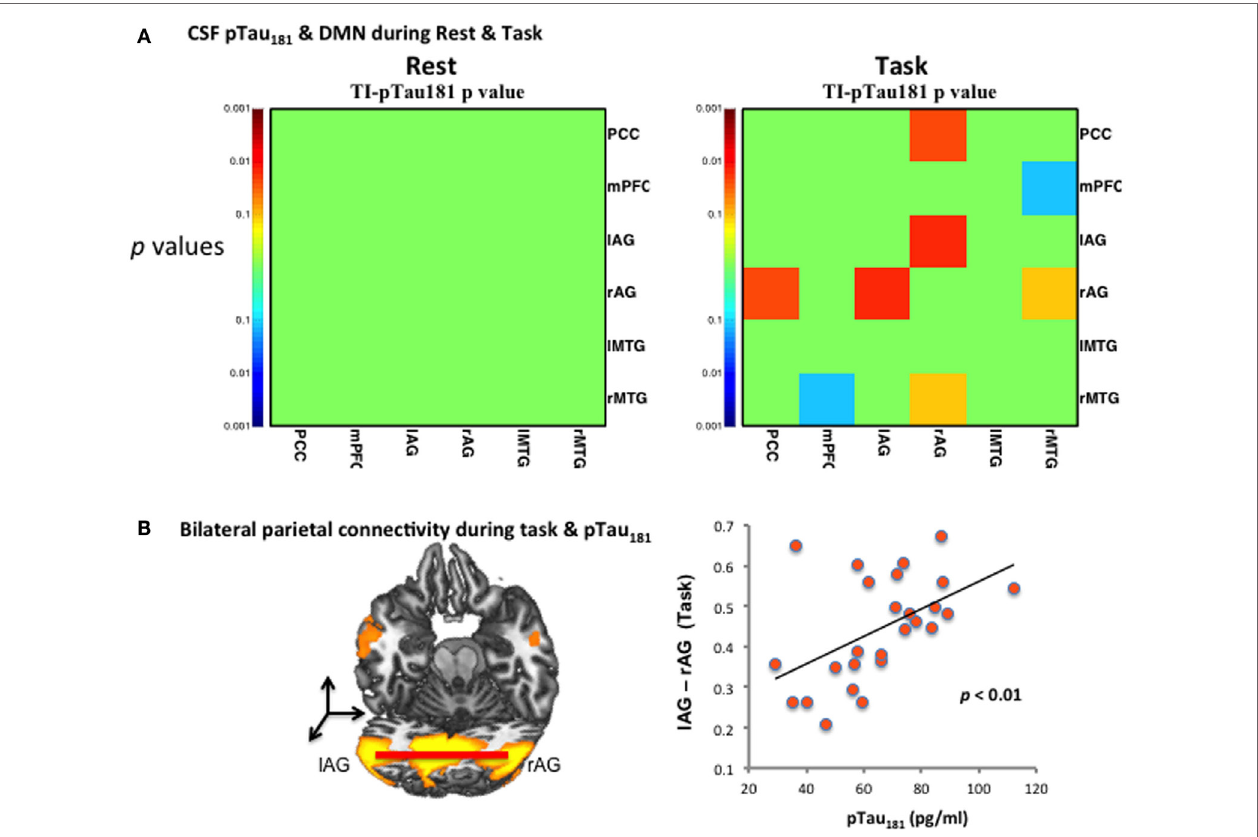
FigUre 3 | csF pTau 181 level and functional connectivity during DMn. (a) CSF pTau 181 during rest and task at various significant p -values; the significant p -values ( y -axis) of the correlation between pTau 181 and connectivity of brain regions were found only during task, but not during resting state; (B) pTau 181 and bilateral inferior parietal connectivity during task. Individuals with stronger lAG–rAG have higher level of pTau 181 , which indicates higher risk of tau-related neural